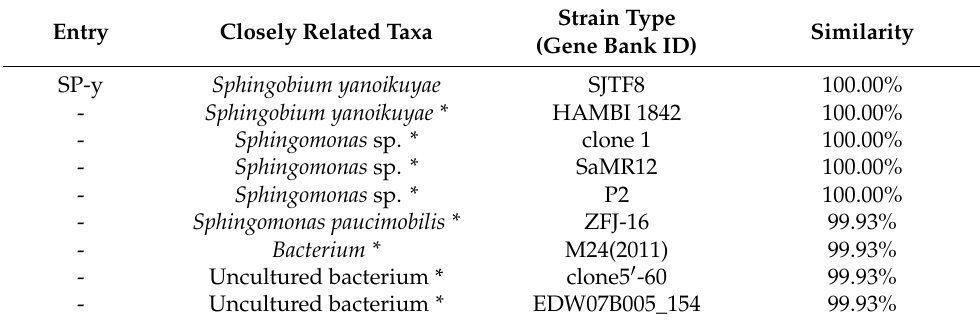
Table 1. Details of bacteria species used in